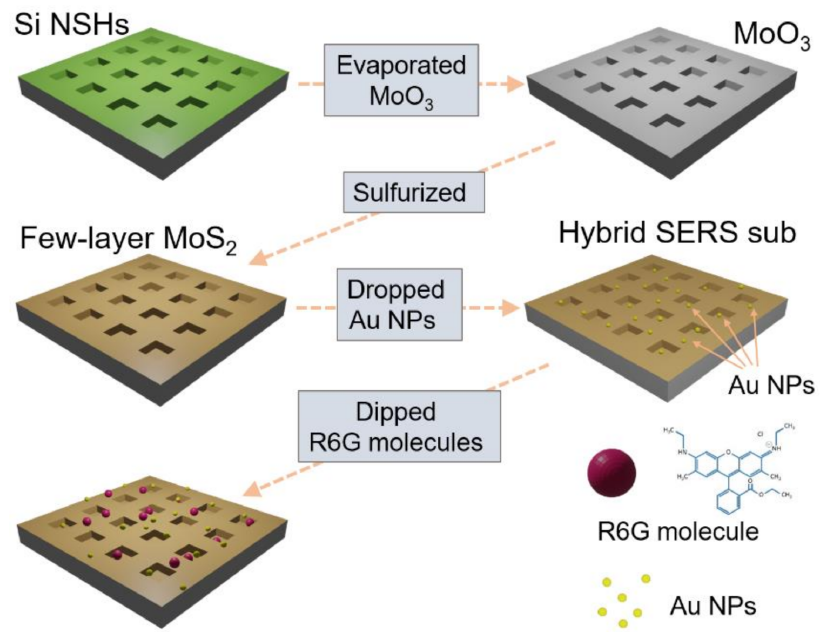
Figure 1. Schematic illustration of the fabrication of MoS 2 decorated with Au NPs on Si